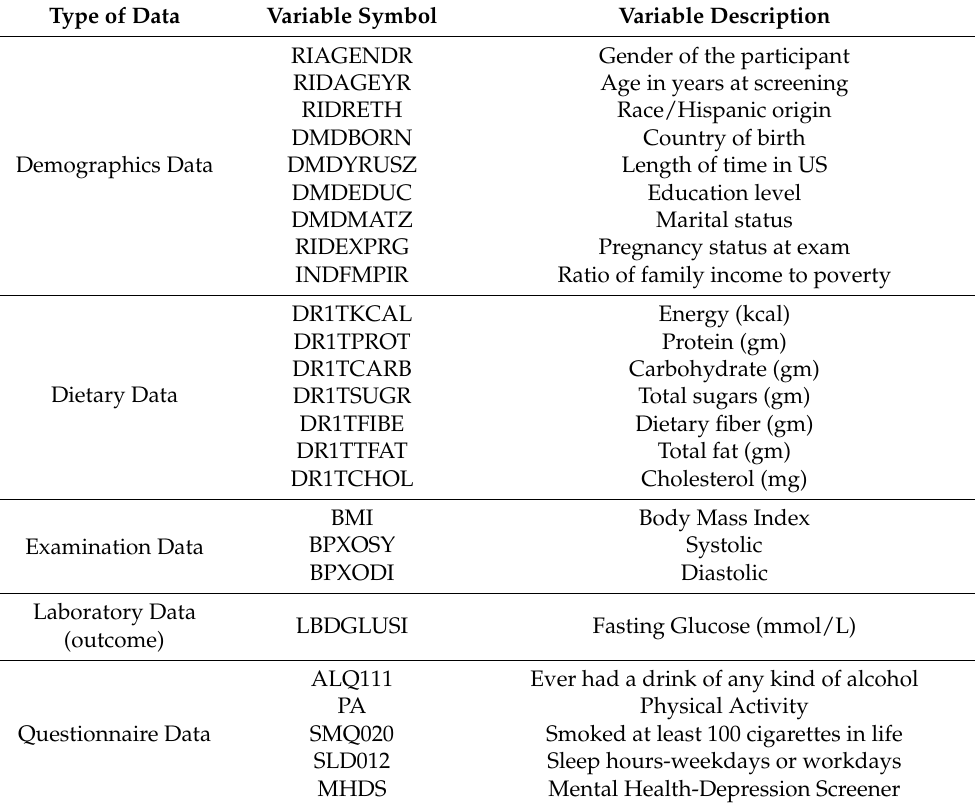
Table 1. Detailed variable description. Type of Data Variable